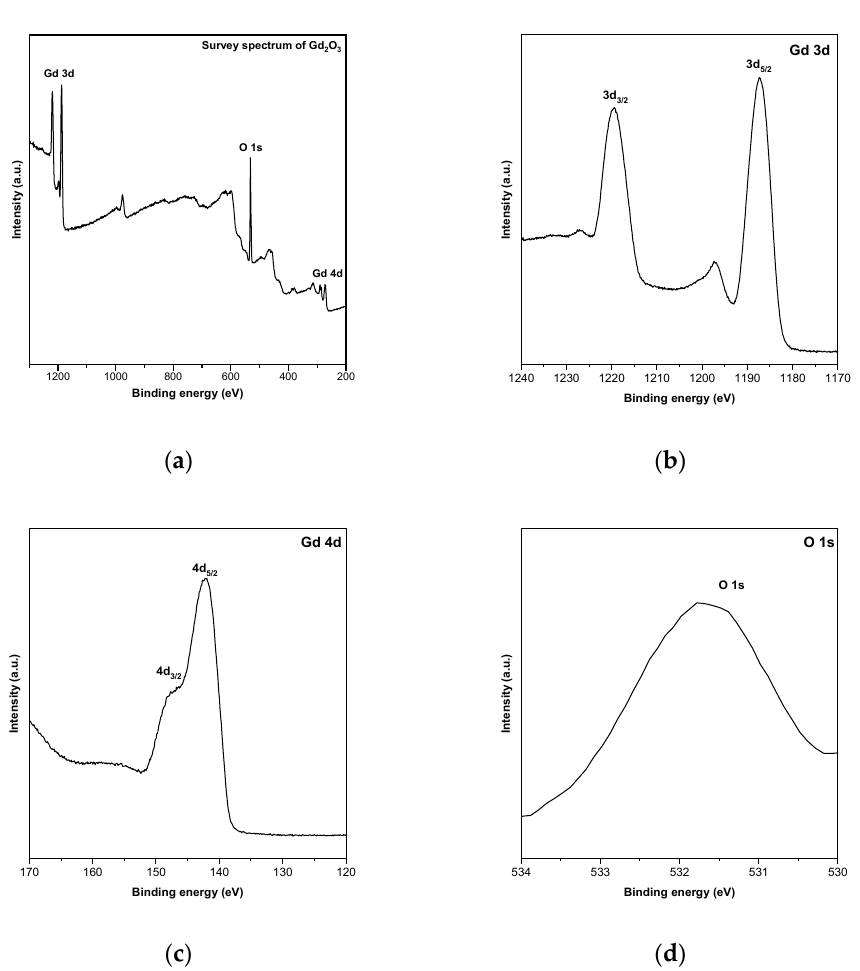
Figure 2. XPS spectra of the Gd 2 O 3 nanoparticles ( a ) full scan survey spectrum, ( b ) Gd 3d, ( c ) Gd 4d and ( d ) O 1s.